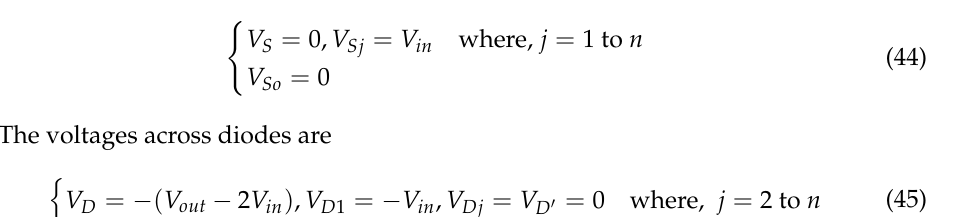
Figure 10. Equivalent circuit of ML converter in mode II(A) when L > L 1 and L = L 2 = L 3 ... L n . The voltages across switches